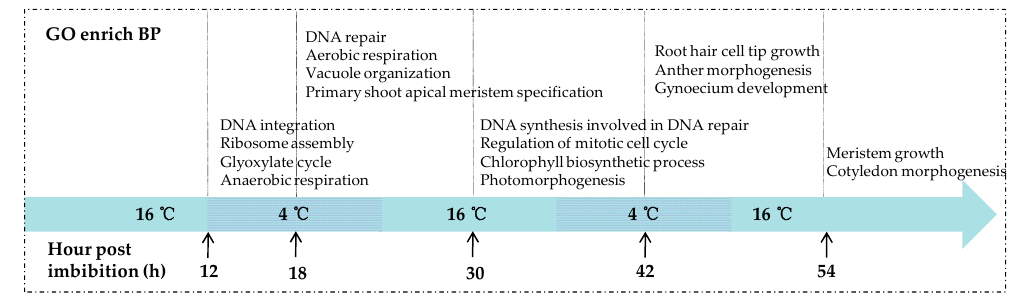
Figure 4. Gene Ontology (GO) categories of up-regulated DEGs were significantly enriched in the biological processes (BP) category at 12, 18, 30, 42, and 54 h post imbibition. The x-axis shows culture temperatures and hours.